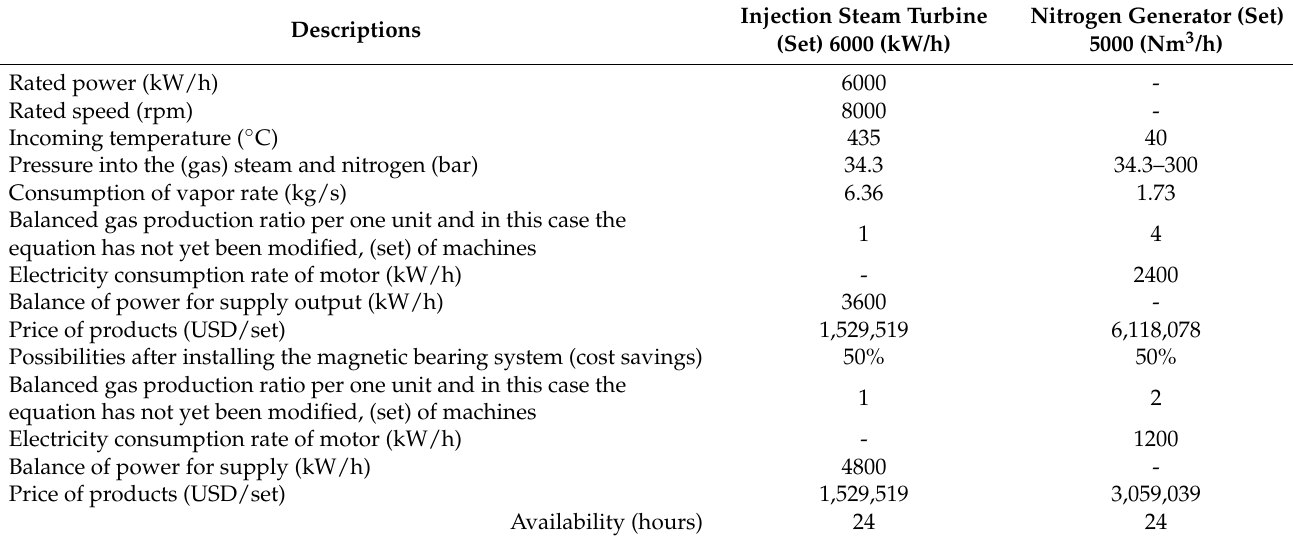
Table 4. Comparison of the conventional injection steam turbine and gaseous nitrogen turbine.